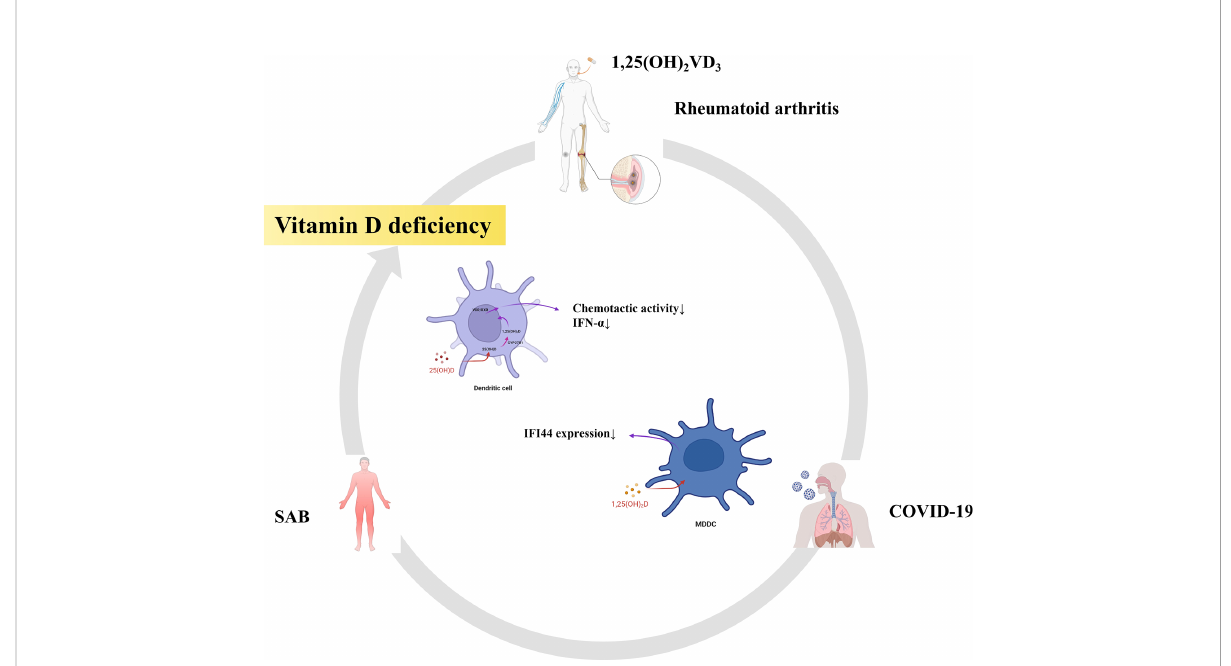
FIGURE 14 RA, SAB, and COVID-19 are often associated with vitamin D de fi ciency. This diagram shows that 1,25(OH) 2 VD 3 is the common target drug for RA, SAB, COVID-19, IFI44, and dendritic